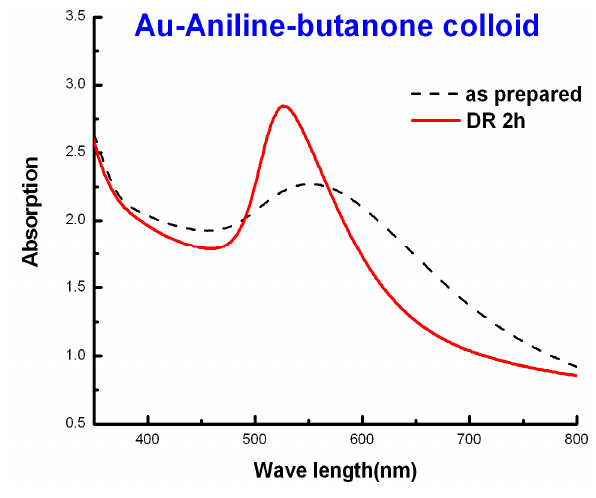
Figure 16. UV-visible spectrum of Au-aniline in butanone before and after digestive ripening, and the digestive ripening process kept going for 2